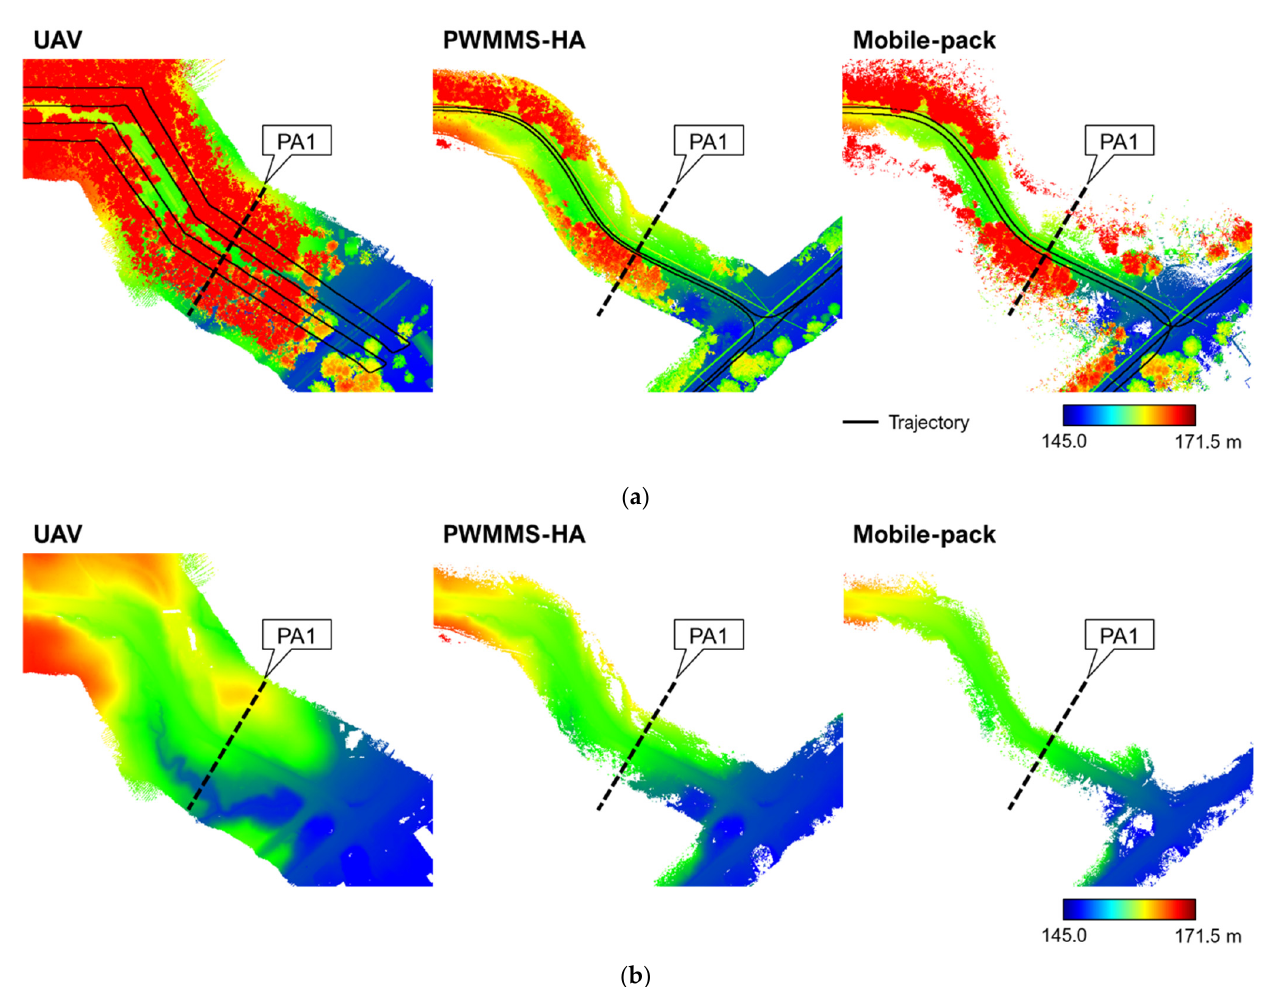
Figure 10. MLMS mapping products showing the ( a ) point cloud and trajectory and ( b ) bare earth point cloud from UAV, PWMMS-HA, and Mobile-pack.